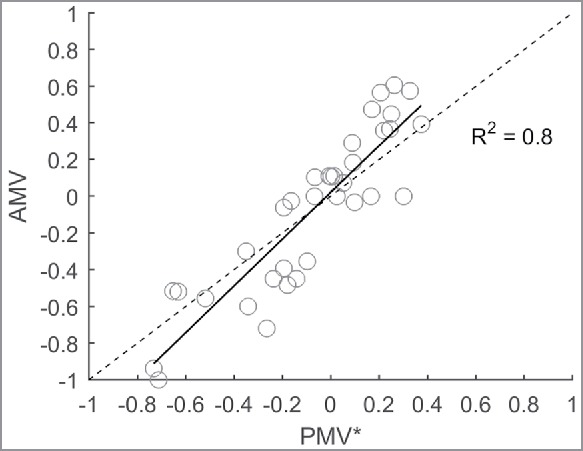
AMV versus PMV* and the line of identity (dashed).